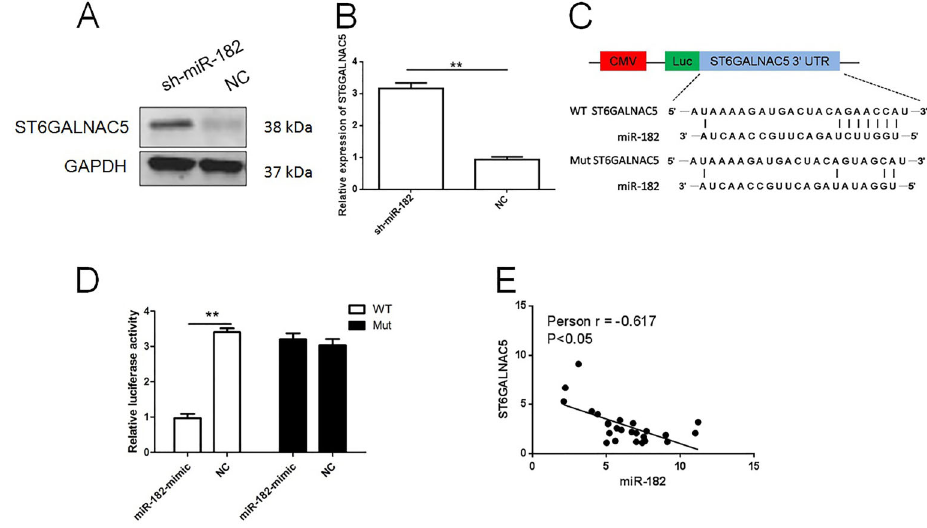
Figure 3. A and B , Western blot and qRT-PCR assays were performed to determine ST6GALNAC5 expression in PC3 cells. C , Bioinformatics analysis revealed that ST6GALNAC5 was a direct target of miR-182. D , Luciferase reporter assay was performed in HEK 293T cells. Data are reported as means ± SD. **P o 0.001 (paired t -test). E , Pearson analysis indicated miR-182 level was negatively correlated with ST6GALNAC5 in prostate cancer tissues. WT: wild type; Mut: mutant; NC: negative